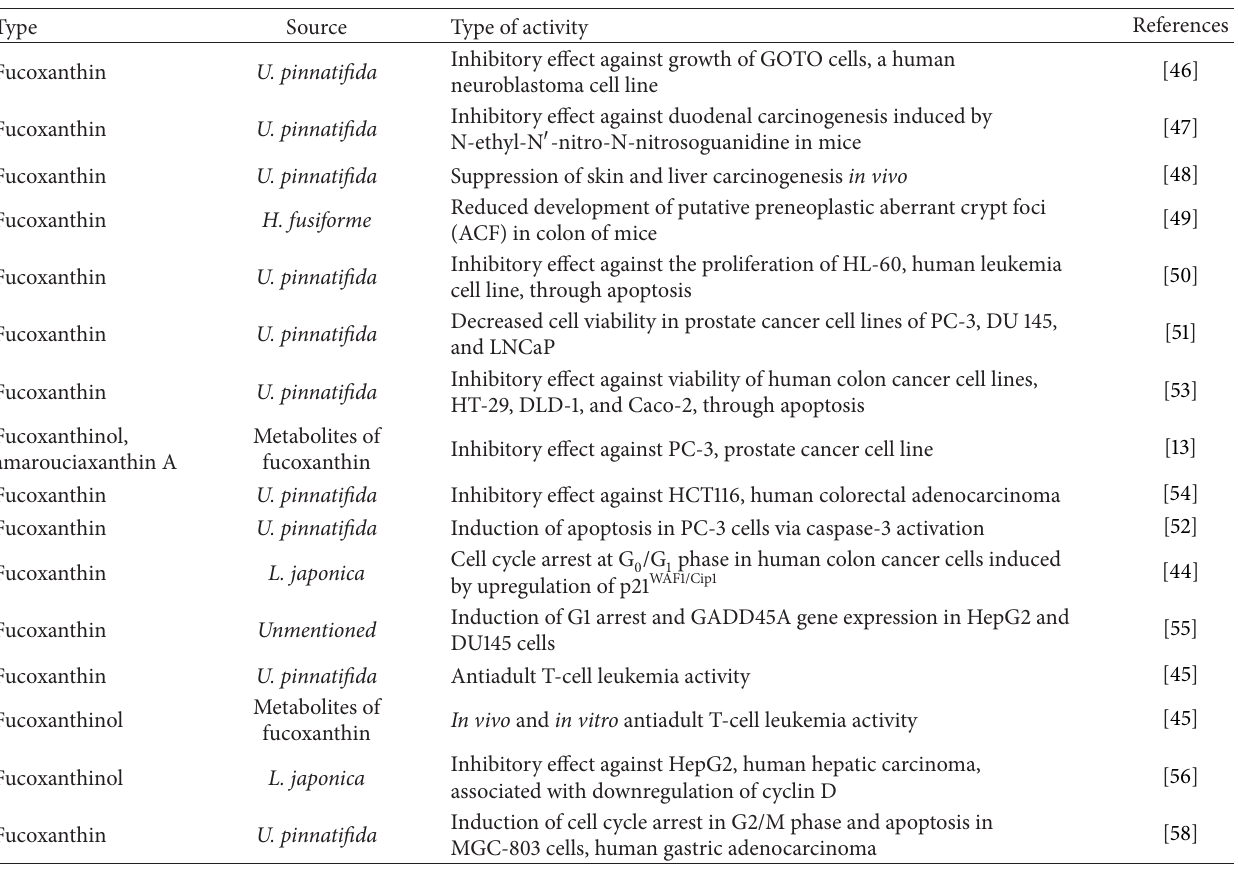
Table 2: Anticancer and antitumor activity of fucoxanthin and its metabolites isolated from brown